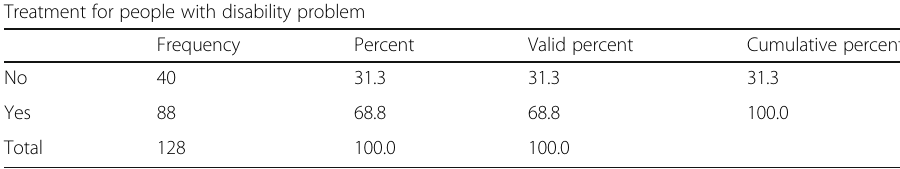
Table 6 Treatment for people with disability problem Treatment for people with disability problem